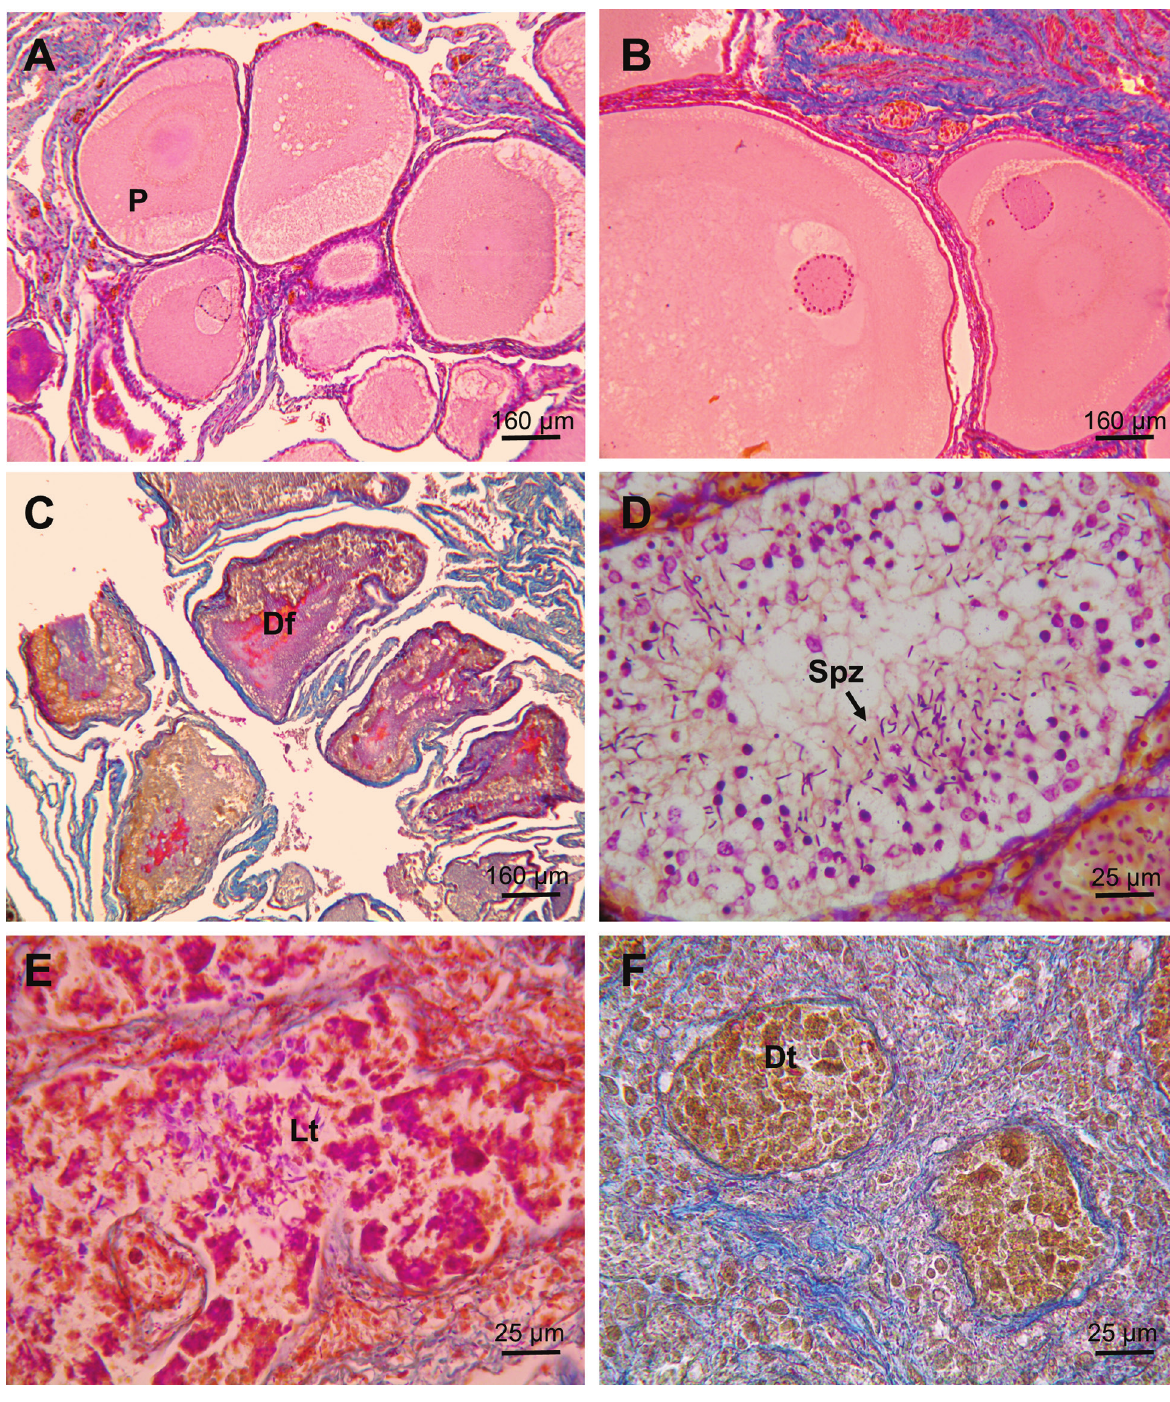
Figure 7. Representative ovary (A–C) and testis (D–E) cross-sections of C. caretta , stained using Mallory’s trichrome stain. A) ID 62083: previtellogenic follicles in different developmental stages. B) ID 53439: follicles with strongly increased diameter at the end of previtellogenesis stage. C) ID 72818: degenerated follicles due to autolysis. D) ID 50816: seminiferous tubule showing active spermatogenesis, including spermatozoa. E) ID 100276: seminiferous tubule degenerating by autolysis and with large lumen. F) ID 123825: degenerated seminiferous tubules with abundant interstitial tissue. Df: degenerated follicles; Dt: degenerated seminiferous tubules: Lt: lumen of the seminiferous tubule; P: previtellogenic follicles; Spz: